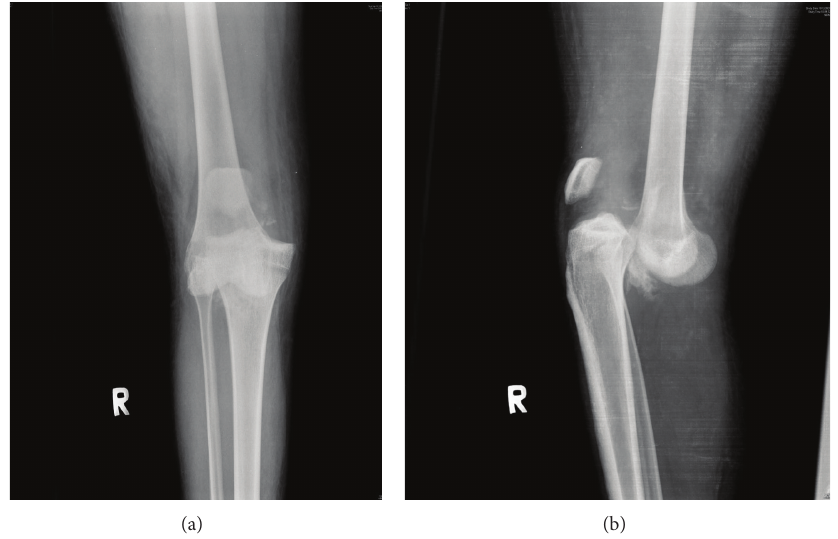
Figure 1: Anterior subluxation of tibia on femur.